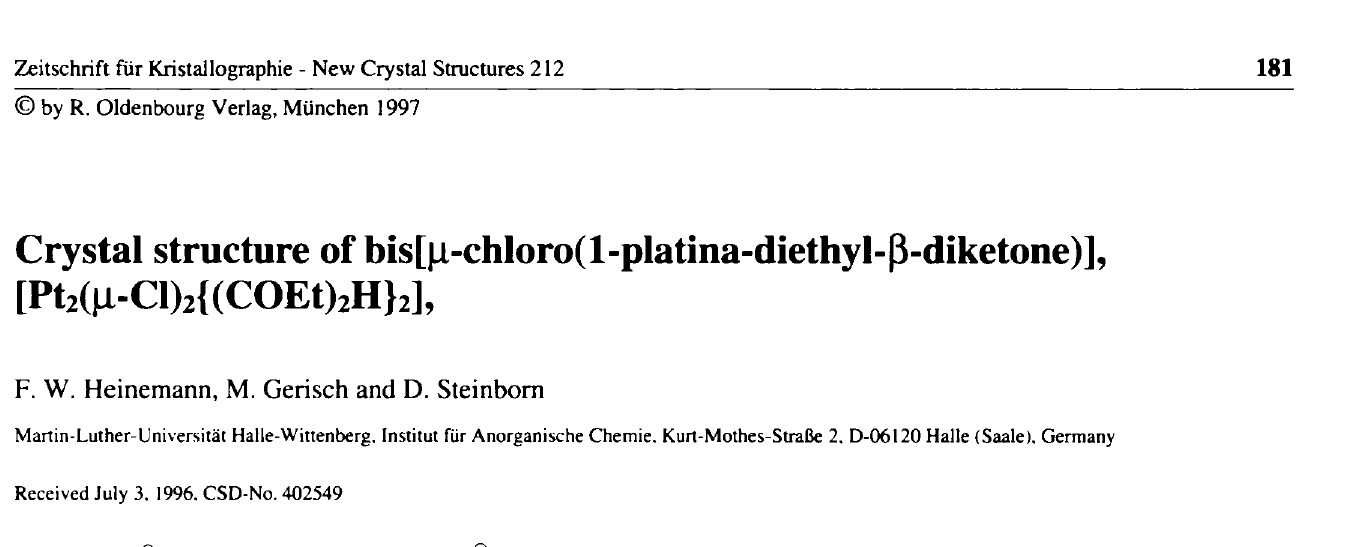
Table 1. Parameters used for the X-ray data collection Crystal: